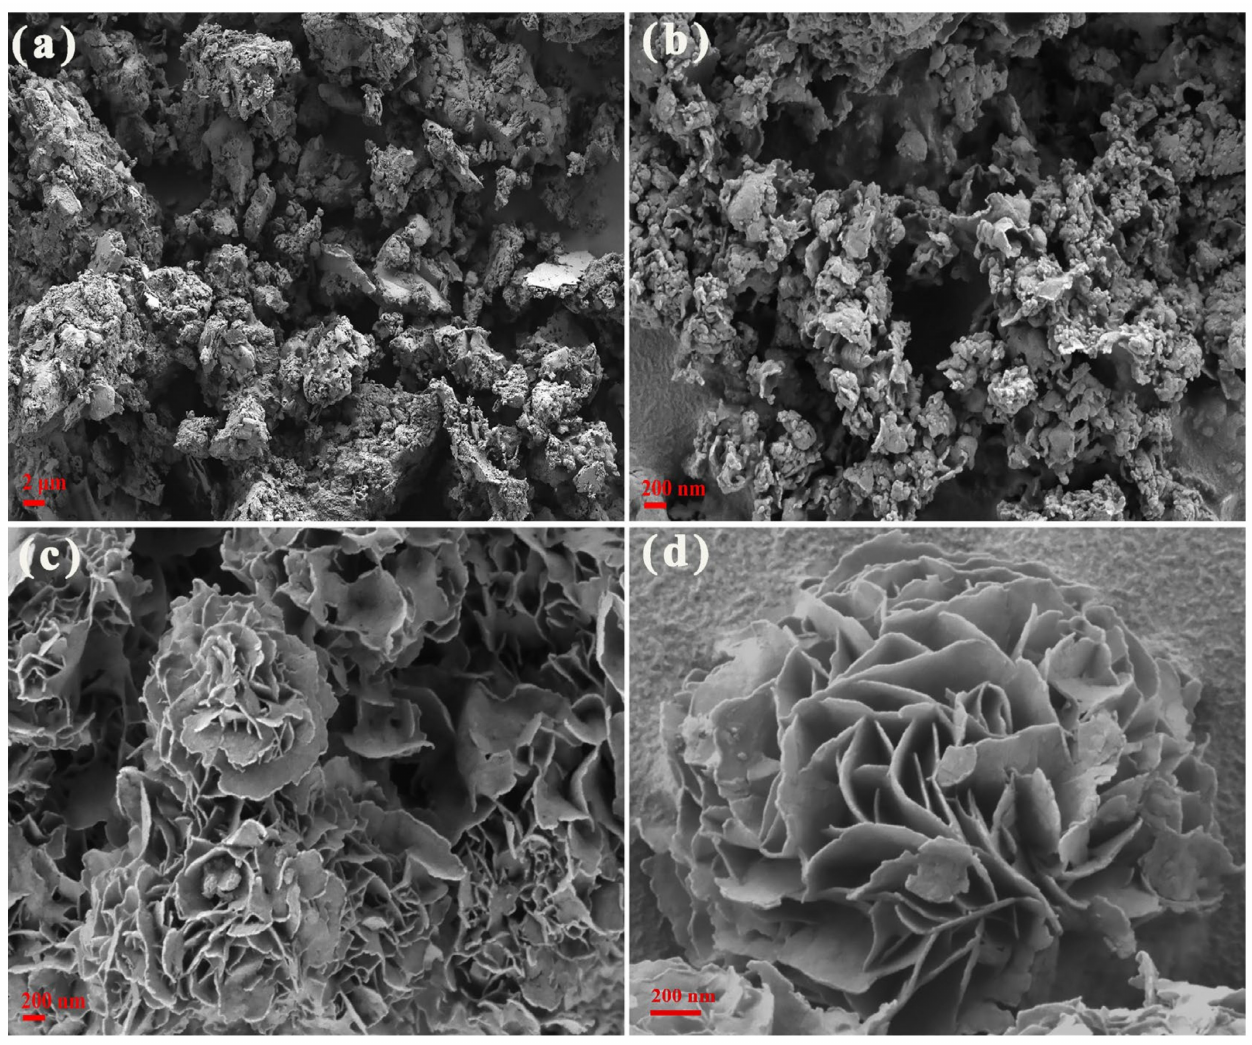
Figure 2. SEM images of bulk CN ( a ), pCN-N nanosheets ( b ), ZIS-Z nanosheets ( c ) and pCN-N/ZIS-Z ( d